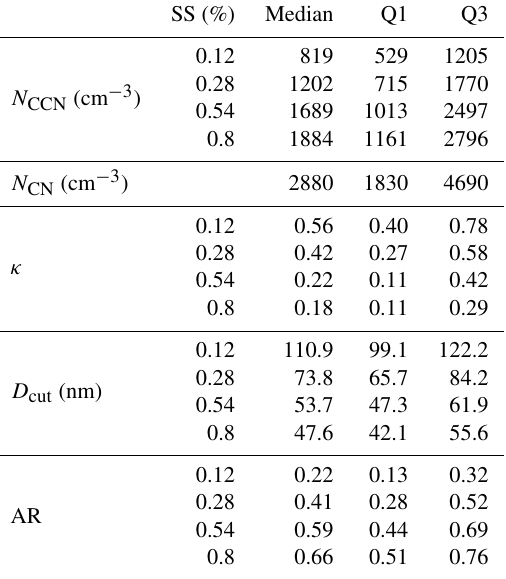
Table 2. Statistics for the number concentrations of the cloud con- densation nuclei ( N CCN ) and total particles ( N CN ), kappa value ( κ ), activation diameter ( D cut ), and activation ratio (AR) under four dif- ferent SS conditions during the study period. SS